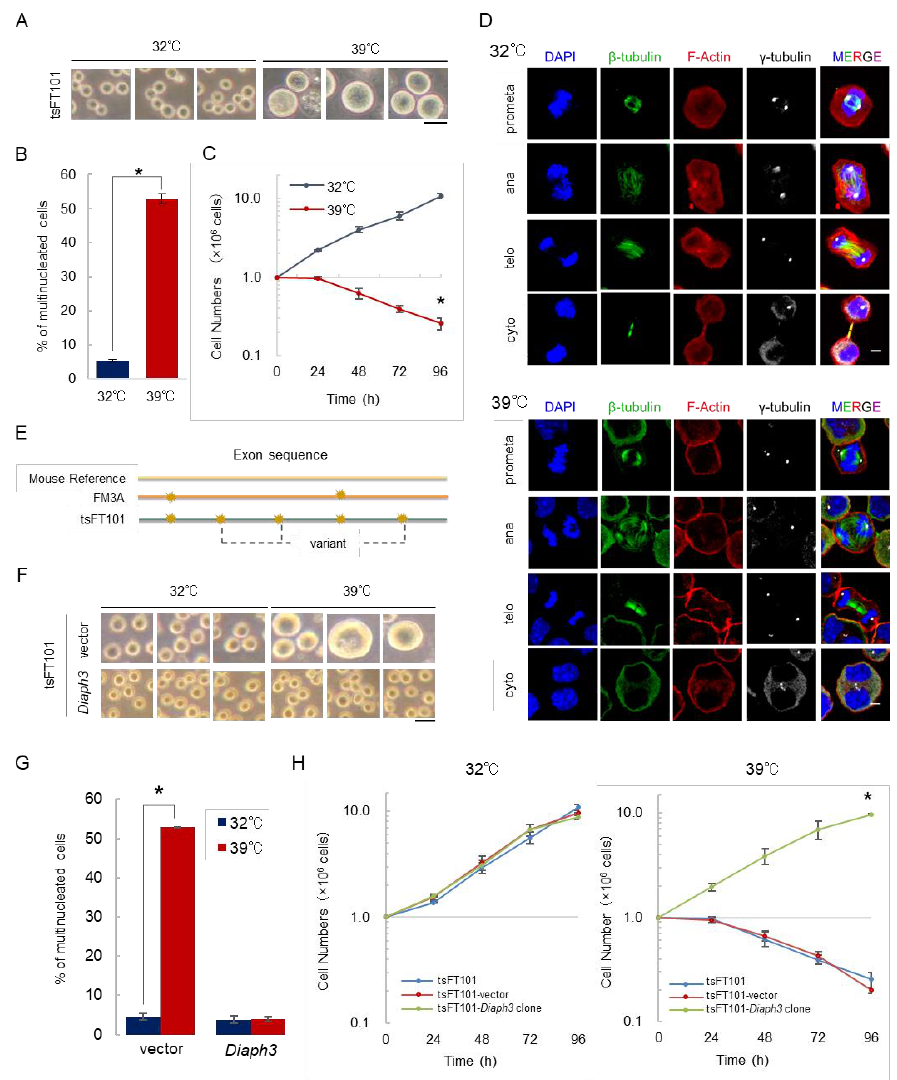
Figure 1. Diaph3 is the gene responsible for temperature sensitivity of tsFT101 cells under high temperature conditions. ( A ) Cell images: tsFT101 cells were cultured at 32 or 39 ◦ C for 96 h under 5% CO 2 . The scale bar indicates 50 µ m. ( B ) The tsFT101 cells were incubated at 32 and 39 ◦ C for 24 h, and DAPI staining was performed. More than 300 cells were measured and the percentage of multinucleated cells was calculated; (error bars: ± SEM); * p < 0.001 (Student’s t-test); 32 vs. 39 ◦ C. ( C ) Growth curve analysis of tsFT101 cells. Cells were seeded at 1.0 × 10 6 cells / dish and incubated at 32 or 39 ◦ C under 5% CO 2 and collected every 24 h to measure the number of cells; (error bars: ± SEM); * p < 0.001 (Student’s t-test); 32 vs. 39 ◦ C. ( D ) To observe the behavior of tsFT101 cells in cell division, they were incubated at 32 and 39 ◦ C for 24 h and then immunostained with antibodies specific for β -tubulin (microtubules: Green) and γ -tubulin (centrosomes: White). DAPI (blue) and Phalloidin (red) were used to stain chromosomes and F-actin, respectively. The scale bar indicates 10 µ m. ( E ) Schematic diagram of exome sequencing analysis. A mouse reference sequence, exon sequence of FM3A cells, and tsFT101 cells were compared to select variants present in tsFT101 cells. Yellow flashes on the diagram indicate the variants observed at the genomes of each cell line. ( F ) Cell images: The tsFT101-vector cells and tsFT101- Diaph3 cells (bulk) were cultured at 32 or 39 ◦ C for 96 h under 5% CO 2 . The scale bar indicates 50 µ m. ( G ) Control tsFT101cells (vector) and tsFT101- Diaph3 cells ( Diaph3 ) were cultured at 32 and 39 ◦ C for 24 h. The percentage of multinucleated cells was calculated as described in ( B ); (error bars: ± SEM); * p < 0.001 (Student’s t-test); 32 vs. 39 ◦ C. ( H ) Growth curve analysis of tsFT101, tsFT101-vector, and tsFT101- Diaph3 clone cells was performed as described in ( C ); (error bars: ± SEM); * p < 0.001 (Student’s t-test); tsFT101 cells (39 ◦ C, 96 h) vs. tsFT101- Diaph3 (39 ◦ C, 96